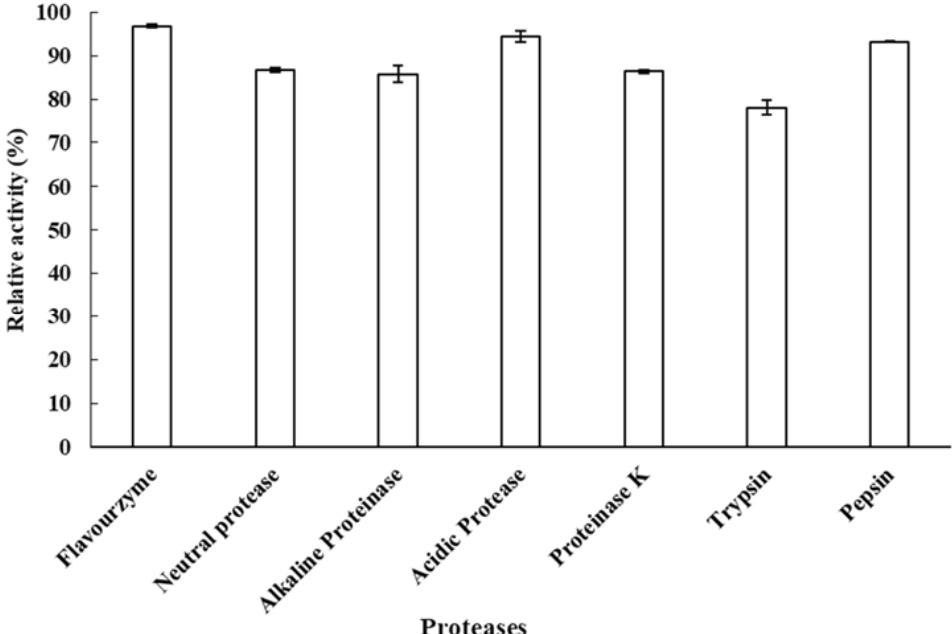
Figure 5. The ability of β -D-fructofuranosidase LcFFase1s to resist various